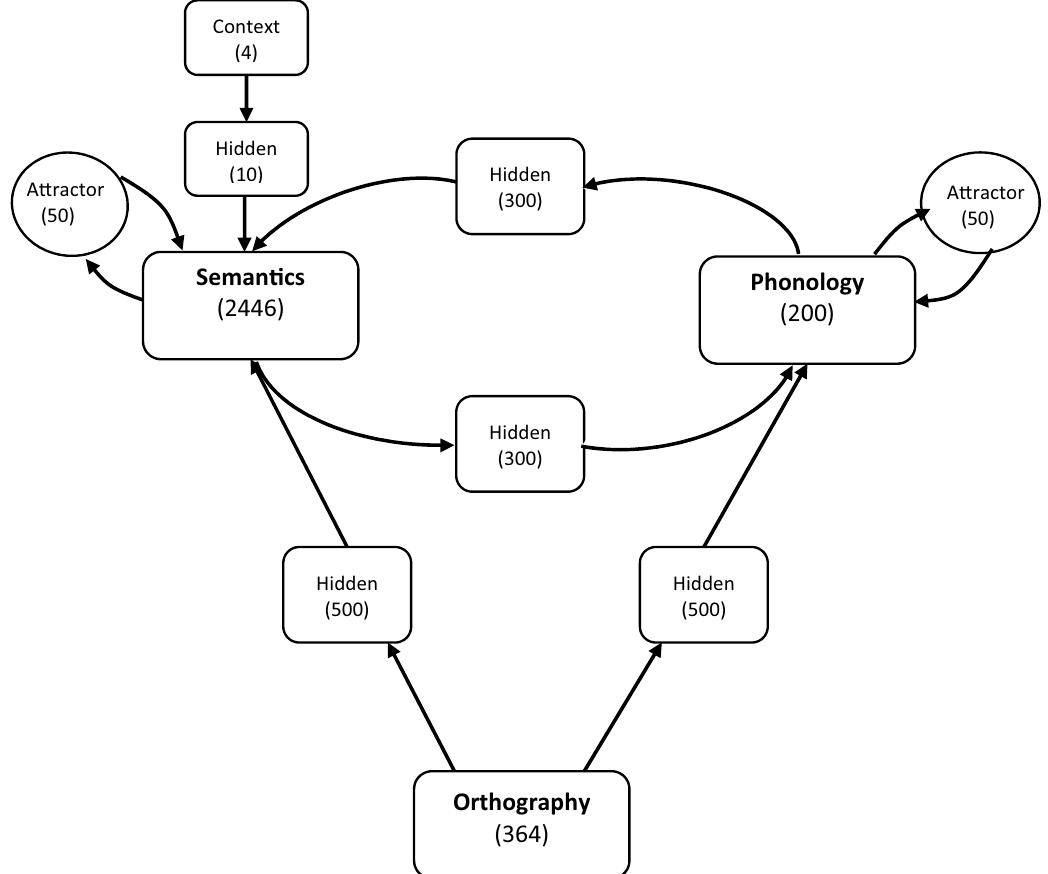
Figure 1. The architecture of the model. Numbers in brackets indicate the number of units in that